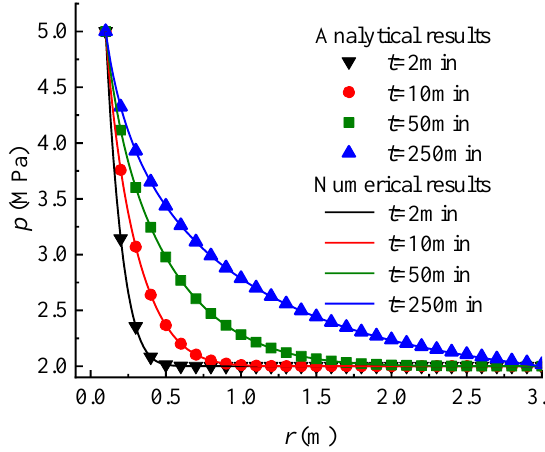
Figure 4. Comparison of the pore pressure versus distance from the wellbore wall between the analytical and the numerical results (FLAC3D) for various times.